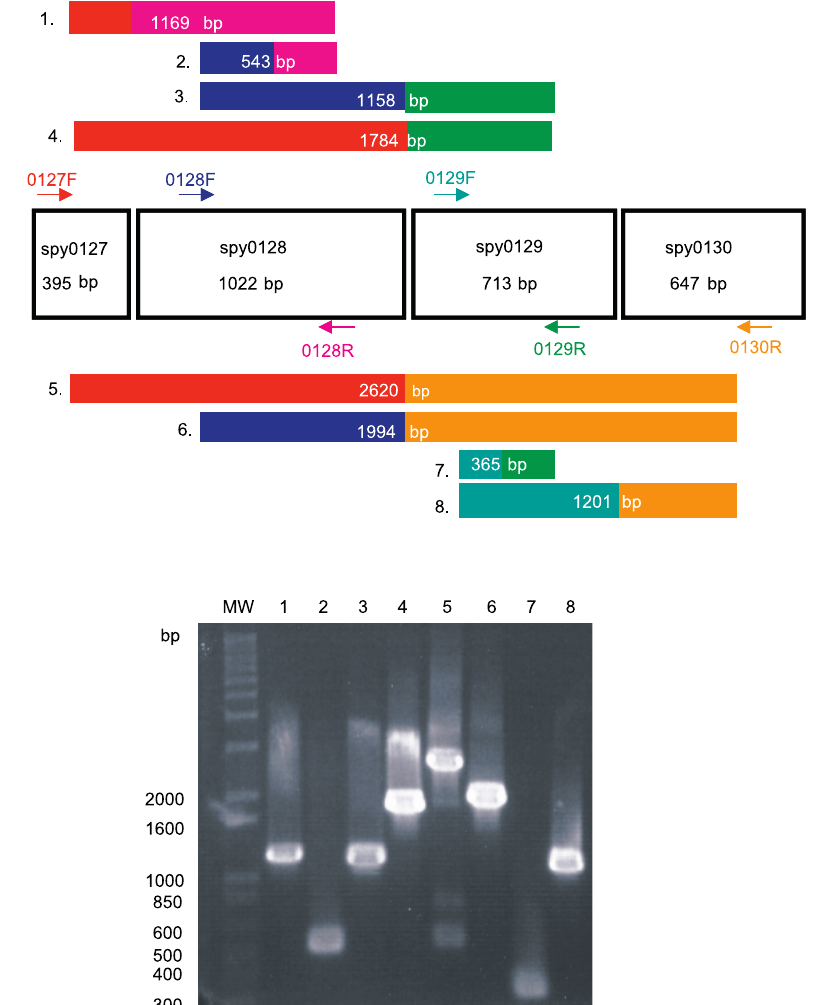
Figure 3. Neighbor Cluster